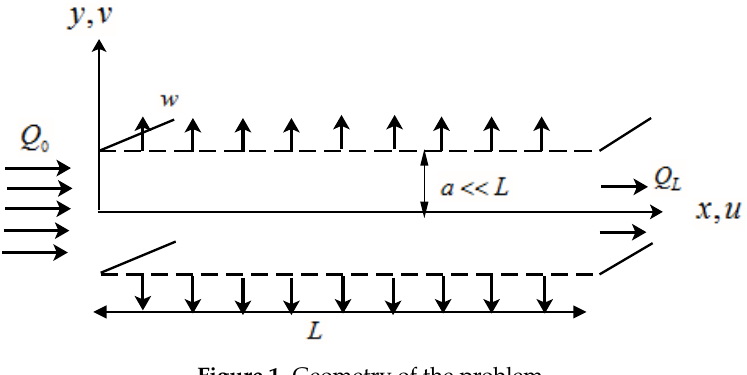
Figure 1. Geometry of the